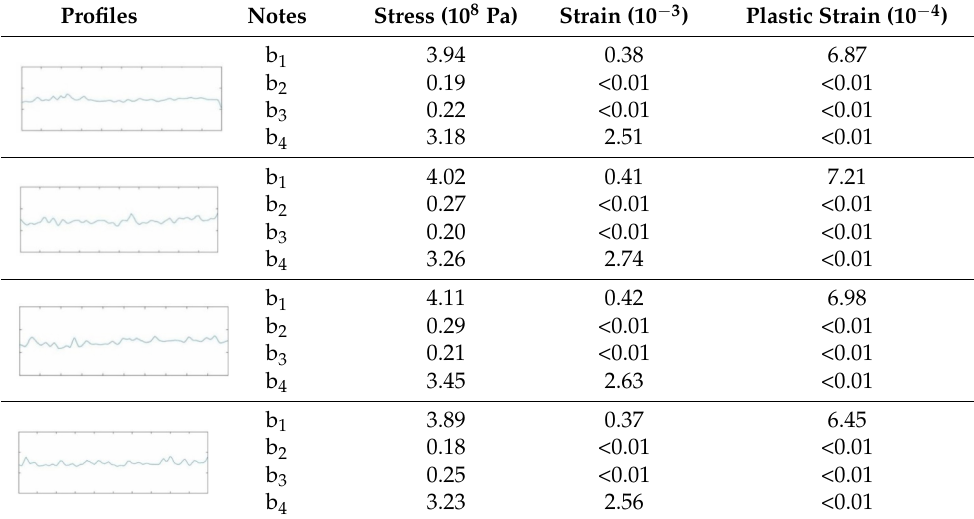
Table 3. Stress strain analysis for different profiles.